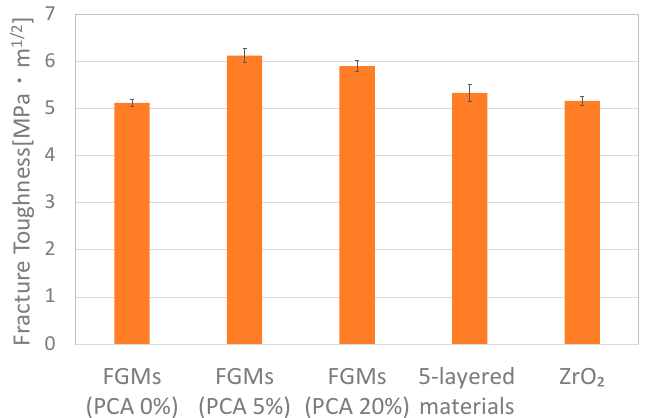
Figure 19. Fracture toughness of the samples of FGMs with PCA (0%, 5% and 20%), 5-layered materials and ZrO 2 single-layer materials after cyclic thermal shock tests.